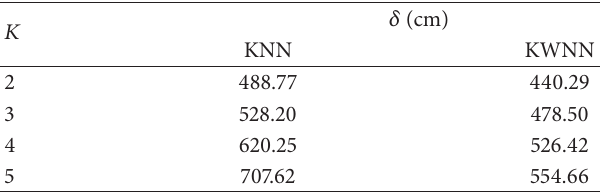
Table 1: Mean positioning error, 𝛿 , for KNN and KWNN algorithm without optimization.